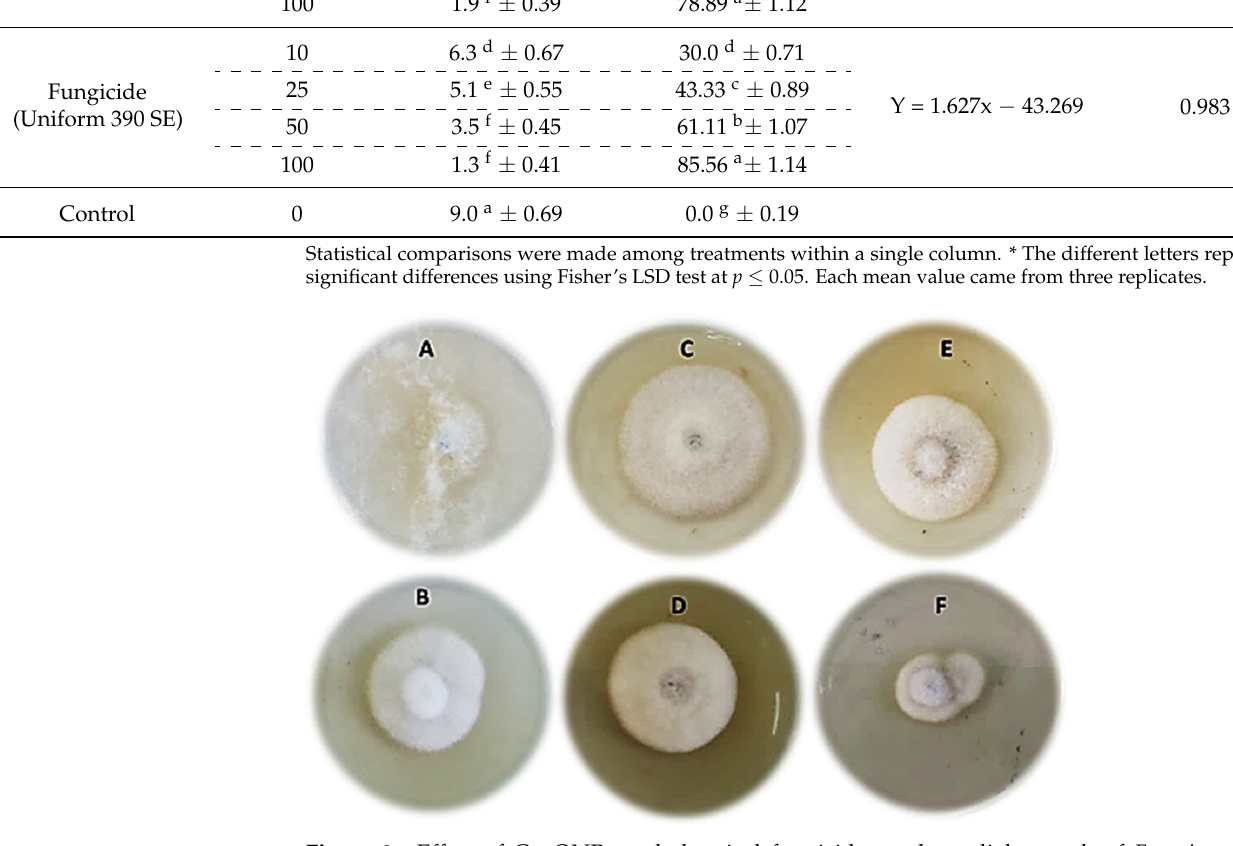
Table 2. Radial growth and inhibition percentage of the Cu 2 ONPs and fungicide against F. solani in vitro with regression equation and degree of correlation. Conc.